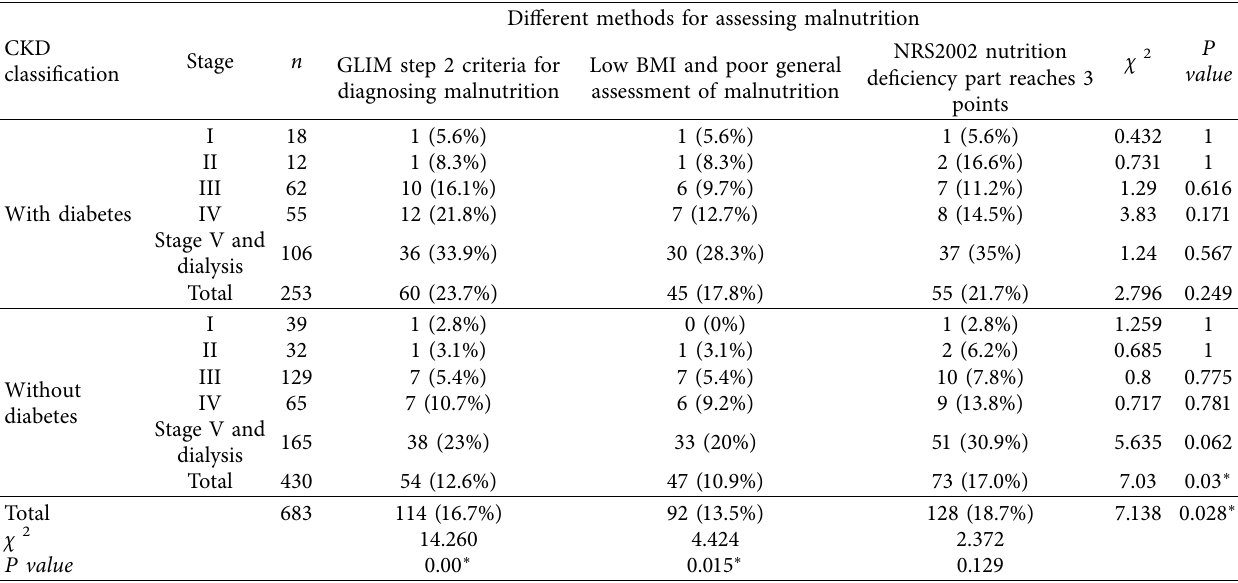
Table 3: Malnutrition in CKD patients with or without diabetes in different stages ( n (%)).